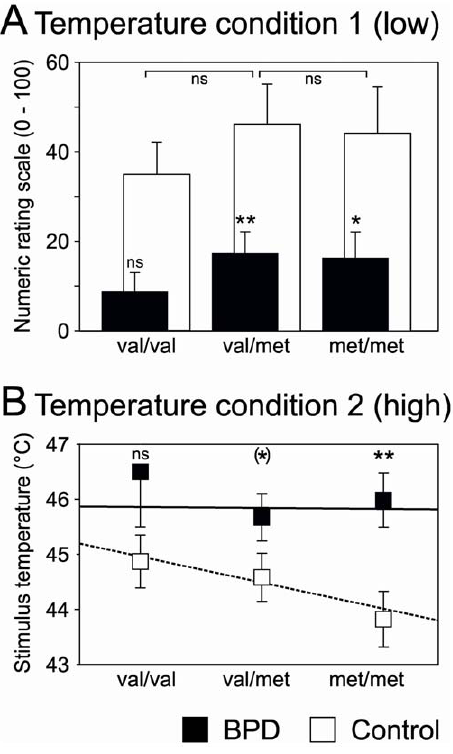
Figure 2. Association between COMT genotype and pain sensitivity. A: Lower heat pain perception in BPD in response to 43 u C does not depend upon the val158met polymorphism. ns p . 0.3, BPD and control, respectively; * p , 0.05; ** p , 0.01, students t-test. B: Stimulus temperatures for the induction of a heat pain sensation of NRS 40 decreases with the number of met alleles in healthy volunteers but not in BPD patients (ns p . 0.19; (*) p , 0.1; * p , 0.05, students t-test).